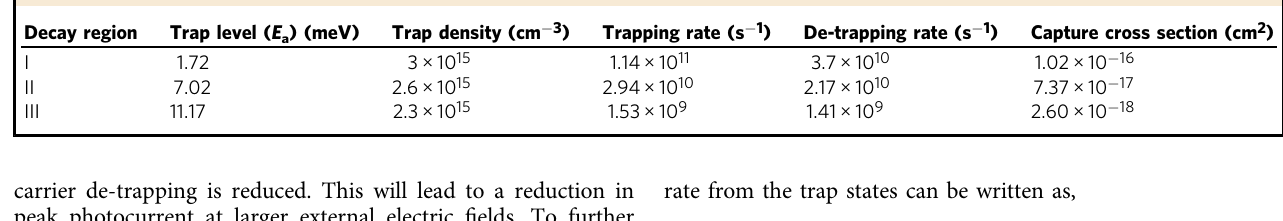
Fig. 4 Ultrafast photocurrent dependence on electric fi eld. a , b The ultrafast photocurrent and corresponding normalized photocurrent under 300 K. c , d The ultrafast photocurrent and corresponding normalized photocurrent under 180 K. The insets are the extracted decay times in regions II and III. Note that the oscillations are a result of impedance mismatch, which slightly varies with devices and do not correspond to an internal physical process. Table 1 Trap